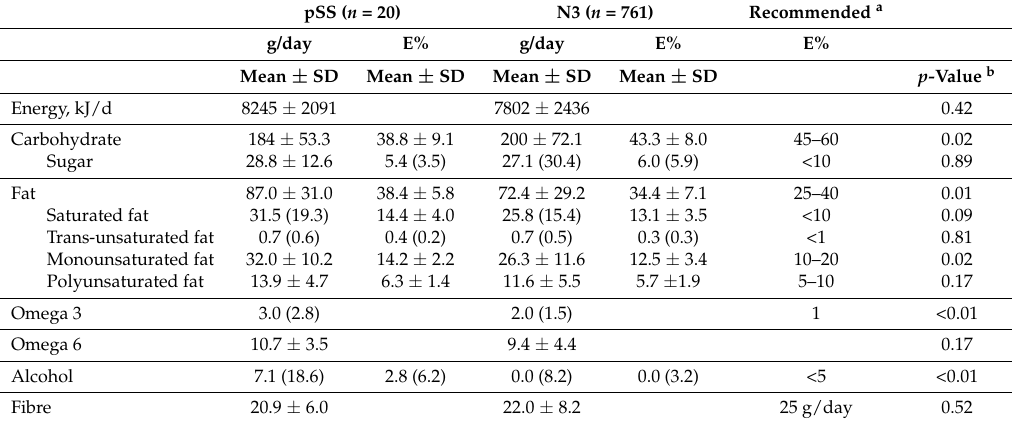
Table 3. Intake of energy and macronutrients among the pSS-patients and the N3 reference